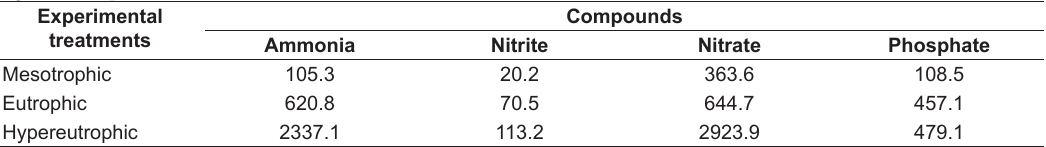
Table 1. Initial concentration levels of nitrogen and phosphate (µg/L) employed on experimental treatments simulat- ing three trophic state